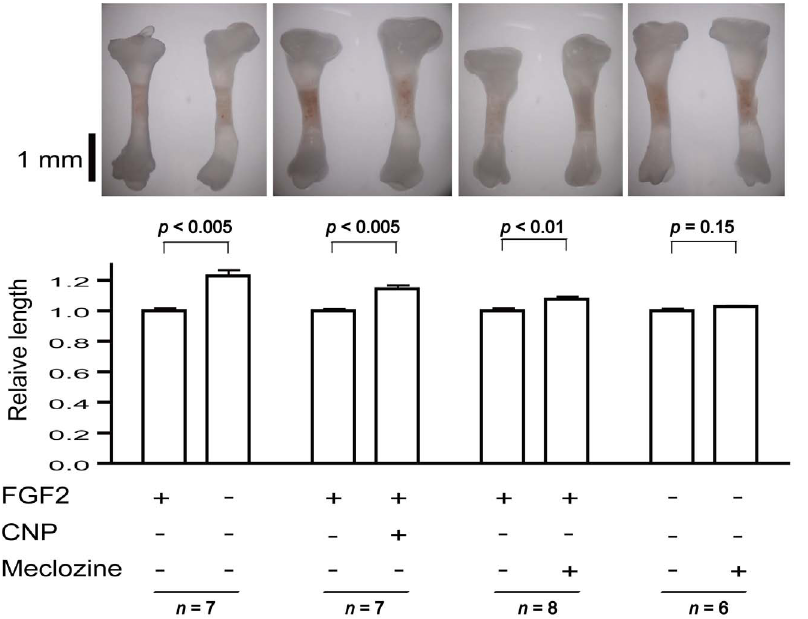
Figure 4. Meclozine increases the longitudinal length of embryonic tibiae with or without FGF2 treatment in bone explant culture. Unstained bilateral tibiae of the same individual were photographed side by side on day six of explant culture. Longitudinal bone lengths were normalized to that of untreated contralateral tibia, and the mean and SD are indicated. FGF2 causes inhibition of longitudinal bone growth. In the presence of FGF2, CNP (0.2 m M) and meclozine (20 m M) significantly increased the longitudinal length of embryonic tibiae. Even without FGF2, meclozine (20 m M) facilitated the growth of embryonic tibiae but without statistical significance (Student’s t-test).